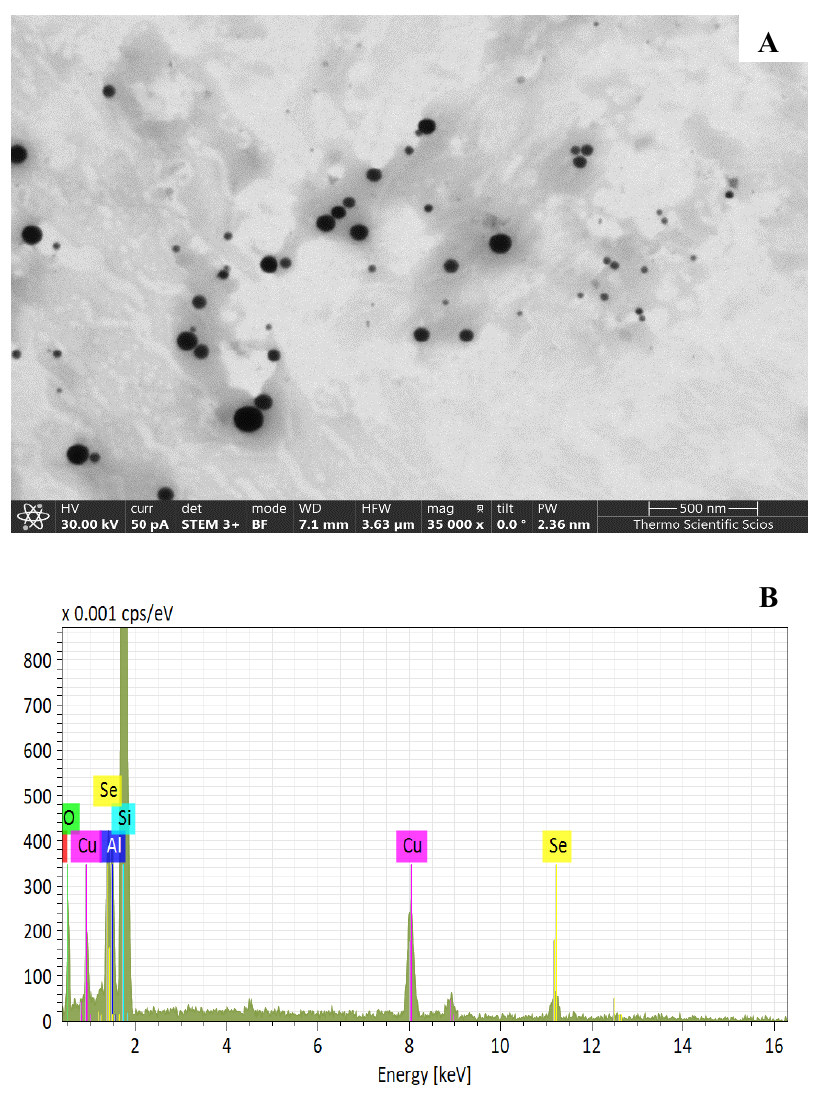
Figure 5. ( A ) The shape and size of chemically synthetized red Se 0 ; ( B ) elemental composition of red elemental particles.